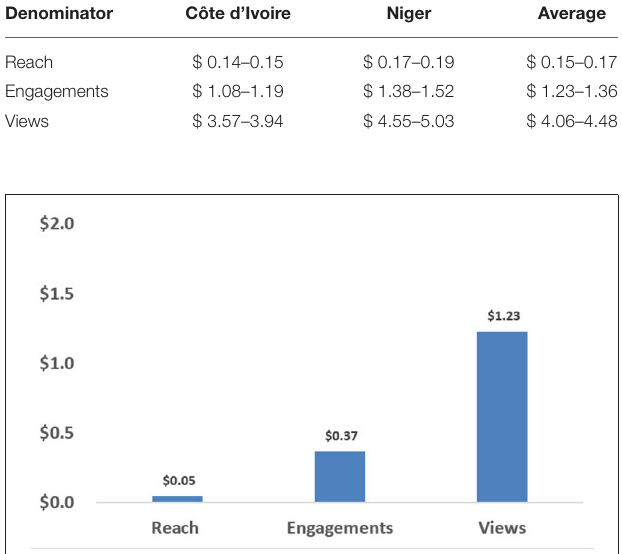
FIGURE 2 | Regional design and production unit